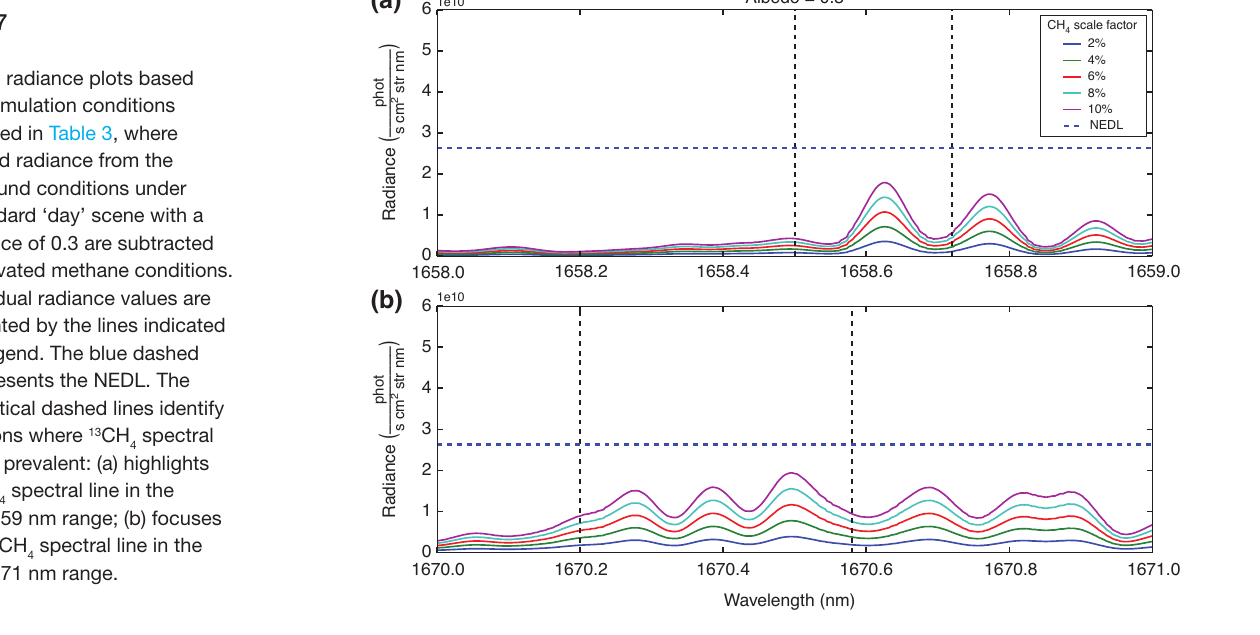
Residual radiance plots based on the simulation conditions highlighted in Table 3, where simulated radiance from the background conditions under the standard ‘day’ scene with a reflectance of 0.3 are subtracted from elevated methane conditions. The residual radiance values are represented by the lines indicated in the legend. The blue dashed line represents the NEDL. The solid vertical dashed lines identify the regions where 13 Ch spectral 4 lines are prevalent: (a) highlights the 13 Ch spectral line in the 4 1658–1659 nm range; (b) focuses on the 13 Ch spectral line in the 4 1670–1671 nm range.